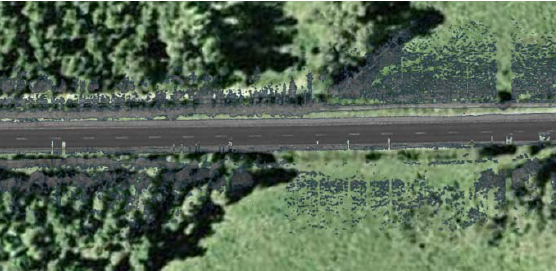
Figure 8. Aerial view of a scanned land road, mapped onto a google maps